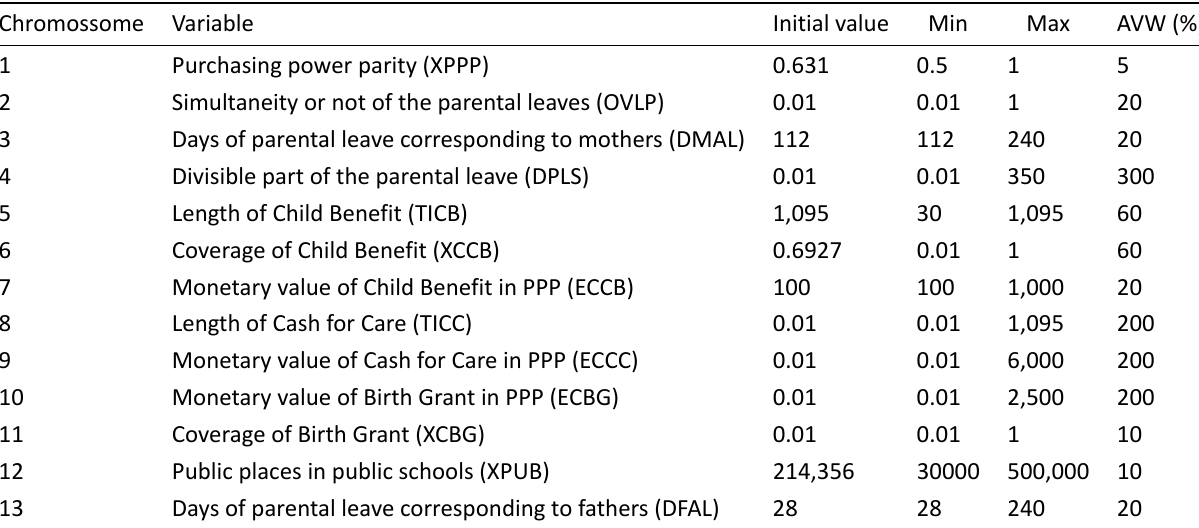
Table 1. Reference values for the